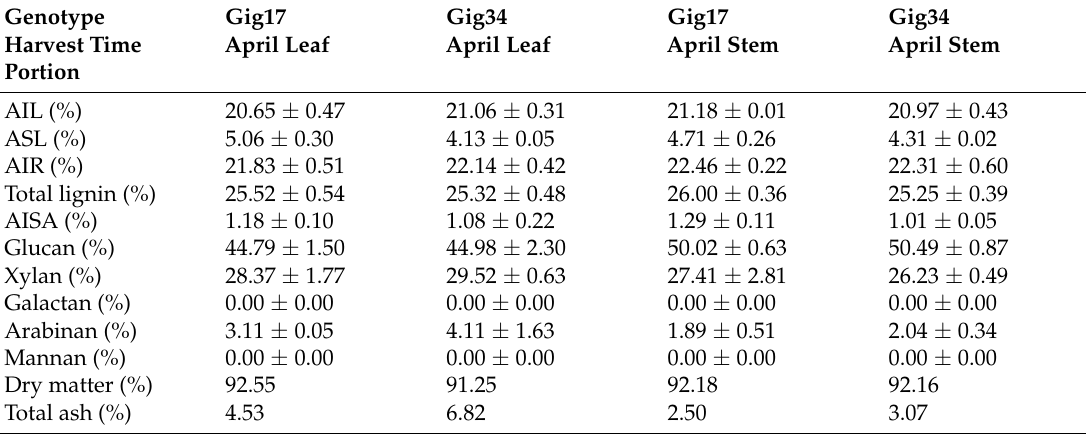
Table 2. Compositional analysis data (according to NREL protocol) of Miscanthus x giganteus